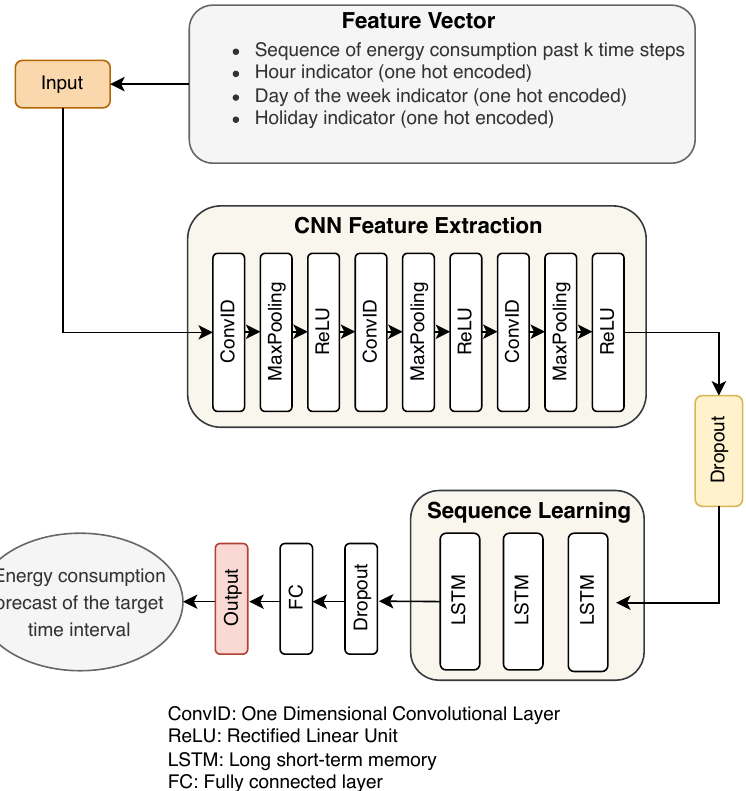
Figure 5. The proposed architecture developed using CNN-LSTM-based deep learning